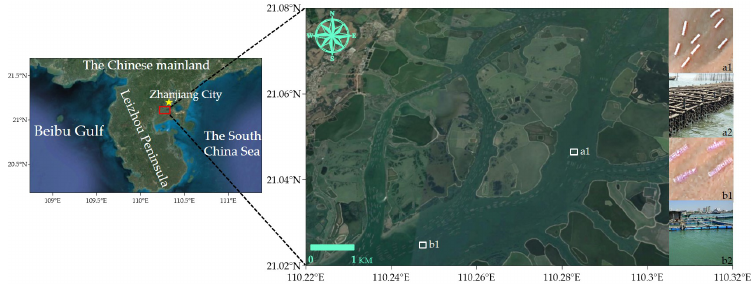
Figure 2. The research area in true color with image examples are raft and cage aquaculture areas on the satellite (a1 and b1, respectively) and ground (a2 and b2,